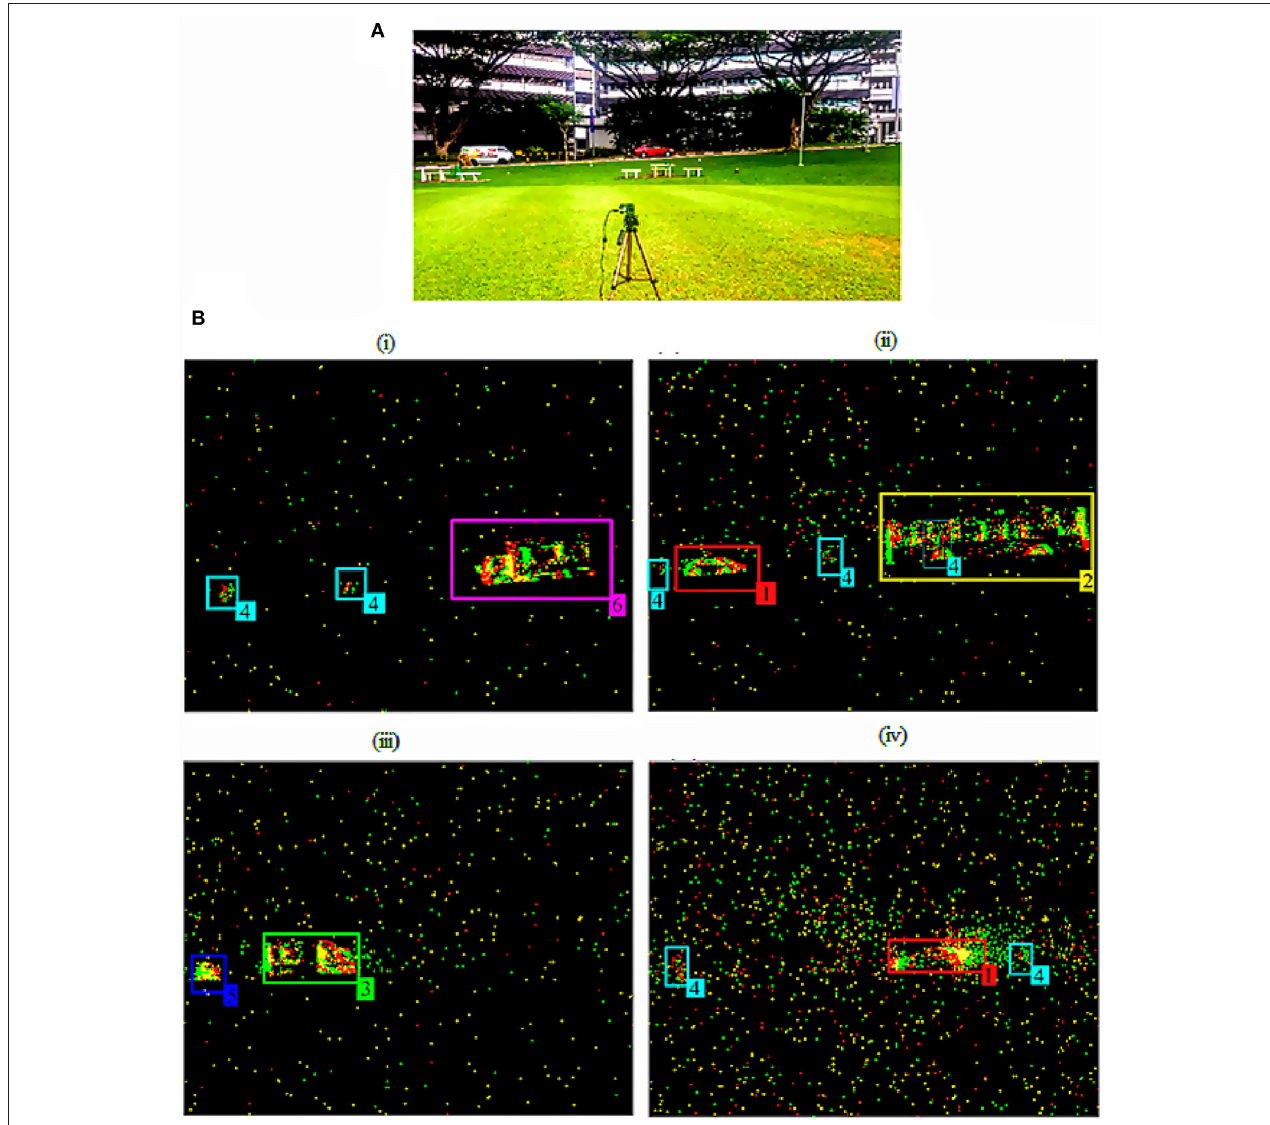
FIGURE 1 | Data Recording from the ATIS setup. (A) ATIS setup to record the moving vehicles and (B) Four Screenshots at (i) 111.78 s from 6:00 p.m. recording, (ii) 39.67 s from 6:30 p.m. recording, (iii) 34.29 s from 6:50 p.m. recording and (iv) 34.48 s from 7:15 p.m. recording showing the moving objects captured by the ATIS in (A) in the scene with six different types of objects (1) Car (Red), (2) Bus (Yellow), (3) Van (Green), (4) Human (Cyan), (5) Bike (Blue), and (6) Truck (Pink) indicated with respective label number and color tracker mentioned in Table 2